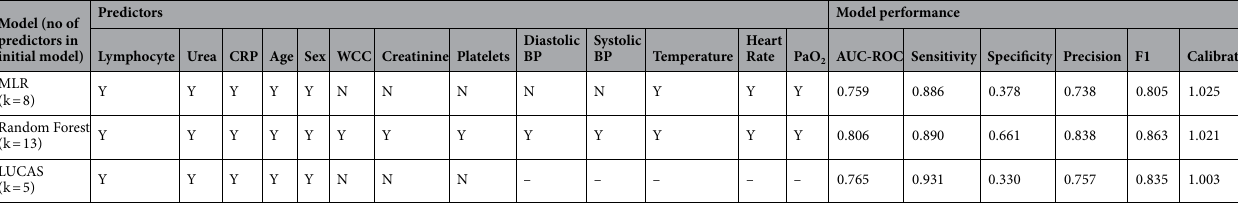
Table 2. Best fit model by Lasso based sequential variable selection. CRP, C-reactive protein; WCC, white cell count; AUC-ROC, area under the receiver operating characteristic curve; BP, blood pressure; PaO 2 , partial pressure O 2 ; ’Y’, retained in the model; ‘N’, excluded after statistical model selection; ‘–’, excluded from the initial model; k, number of